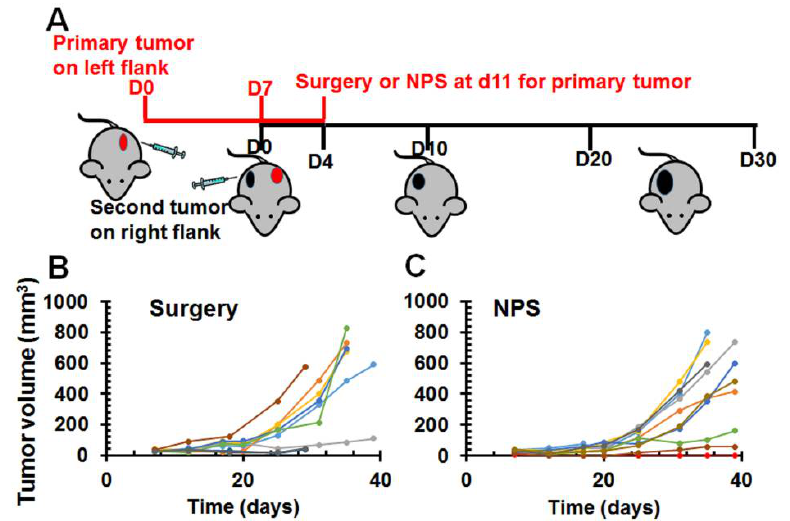
Figure 2. Growth curves of the second challenge tumors. Tumor-free animals after IRE or NPS treatment were challenged subcutaneously with 0.5 × 10 6 Pan02 cells. IRE ( n = 5): tumor-free mice after heat-assisted IRE treatment (100 µ s, 1 Hz, pulse number 90 and electric fields 2100 V/cm). NPS ( n = 15): tumor-free mice after NPS treatment using pinch electrode (200 ns, 30 kV/cm, 2 Hz with 800–1200 pulses). Each line represents a single tumor growth in one mouse.